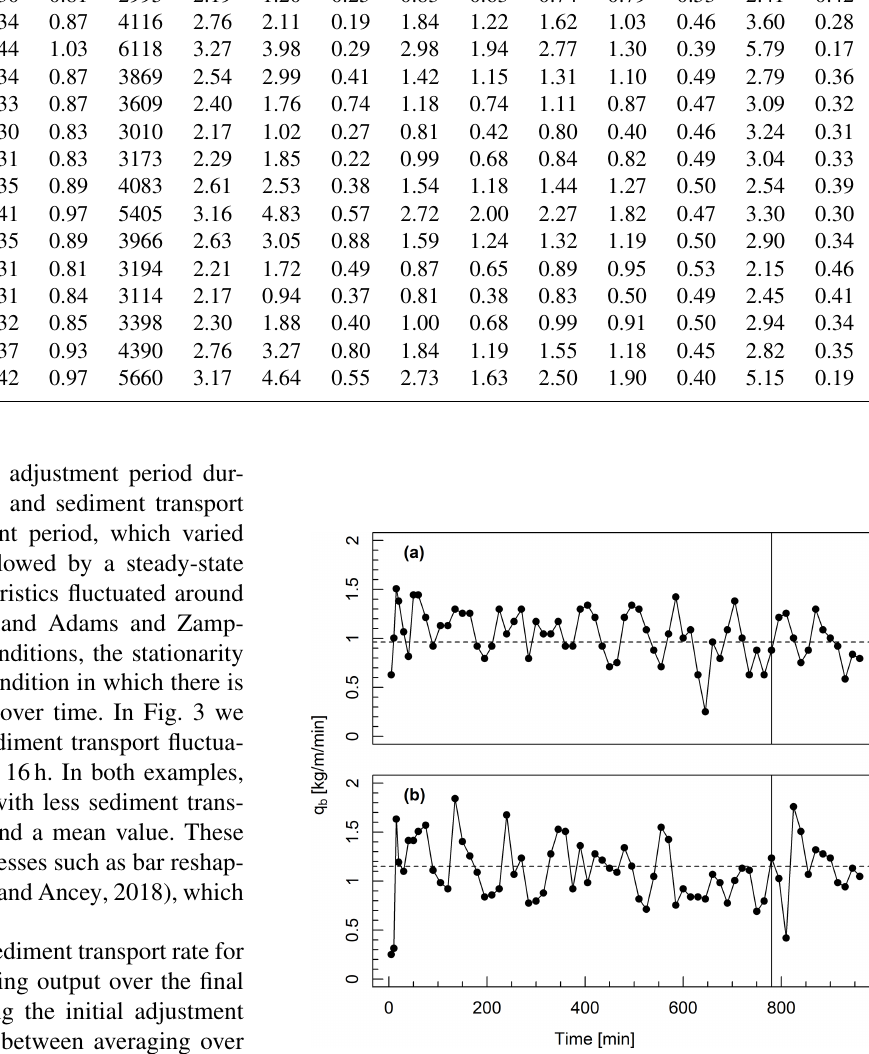
Figure 3. Width-averaged bedload transport over time in two exper- iments with different widths but similar reach-averaged shear stress: (a) experiment 1b ( W = 0 . 30m, ¯ τ = 2 . 34Pa) and (b) experiment 4b ( W = 0 . 60m, ¯ τ = 2 . 28Pa). The beginning of the time window over which bedload transport is averaged is indicated by the solid vertical line, and mean transport over this period is indicated by a horizontal dashed